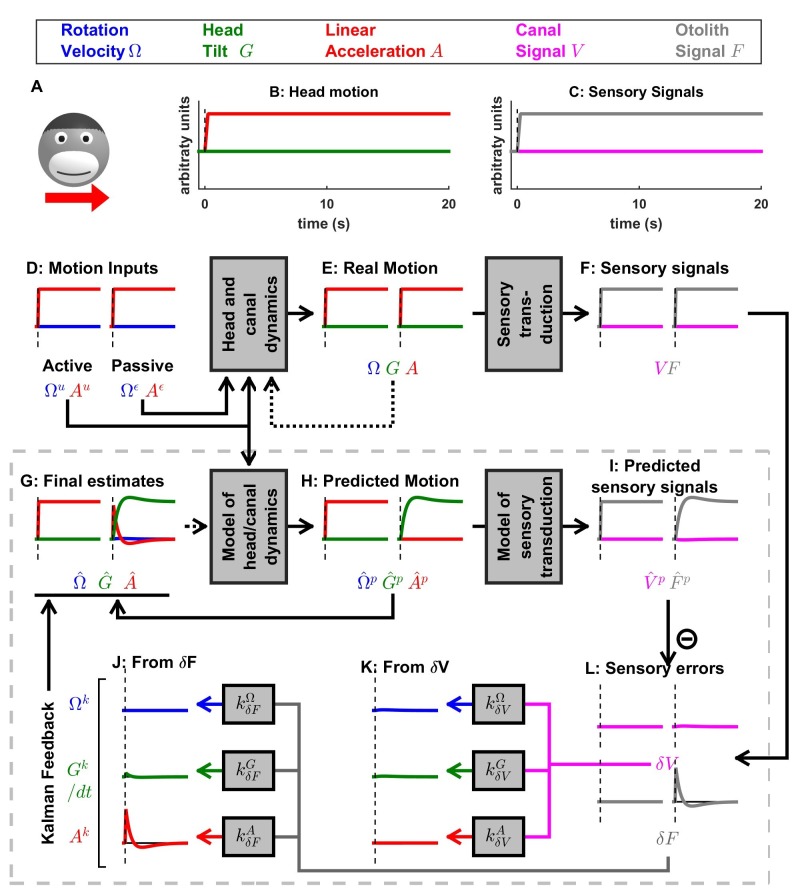
Long duration translation, demonstrating the time course of the somatogravic effect.Note that G^ slightly overshoots F transiently: this is the indirect consequence of an additional feedback from δF to C^ (not shown here for simplicity; but detailed in Laurens and Angelaki, 2011). In this simulation, we observe that the tilt estimate G^ develops until its magnitude matches the otolith signal F. At this point, the corresponding predicted otolith signal F^p= G^p matches the real signal F. Therefore, the otolith error, δF, as well as the net acceleration estimate, A^, vanish. This feedback, which allows the otolith organs to create a rotation signal, has only a low magnitude and a slight effect on the dynamics of G^ in this simulation. In general, however, it allows the otolith system to detect low-frequency head rotation velocity relative to gravity (Figure 6—figure supplement 3; see also Angelaki and Hess (1995a),b; Laurens et al. (2010); Laurens and Angelaki, 2011).